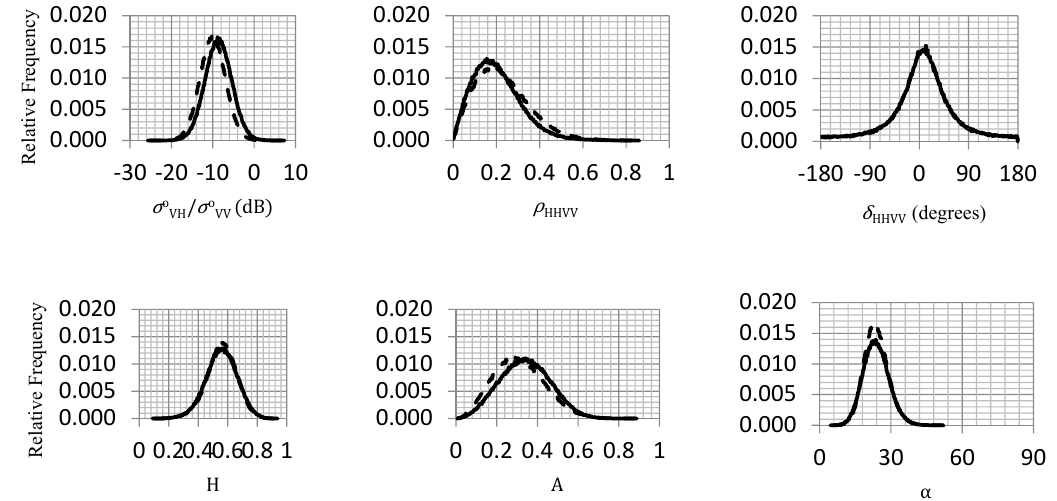
Figure 4. Histograms of polarimetric SAR parameters for the case of RADARSAT-2 data. Solid line refers to FYI and dashed line refers to OI.